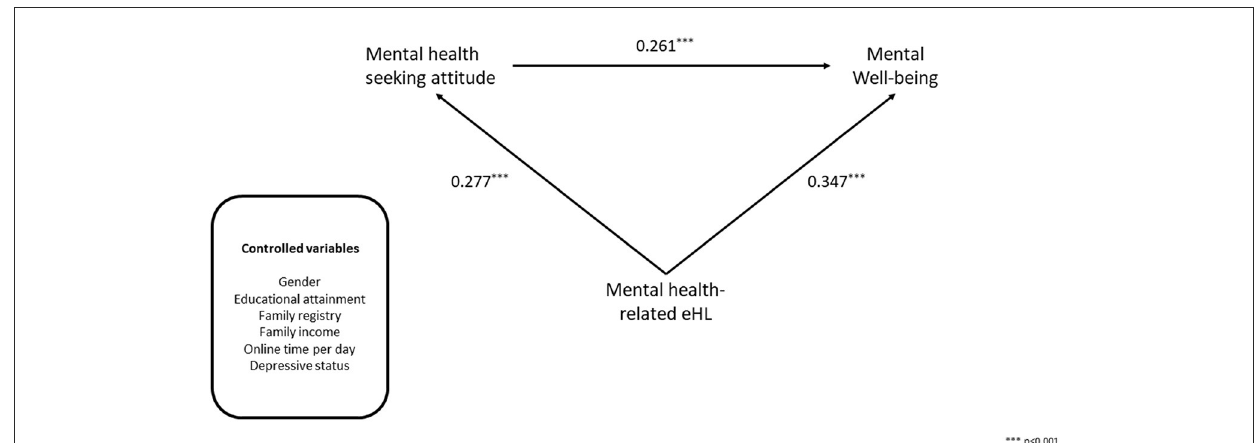
FIGURE2 The standardized solution for significant paths of the structural